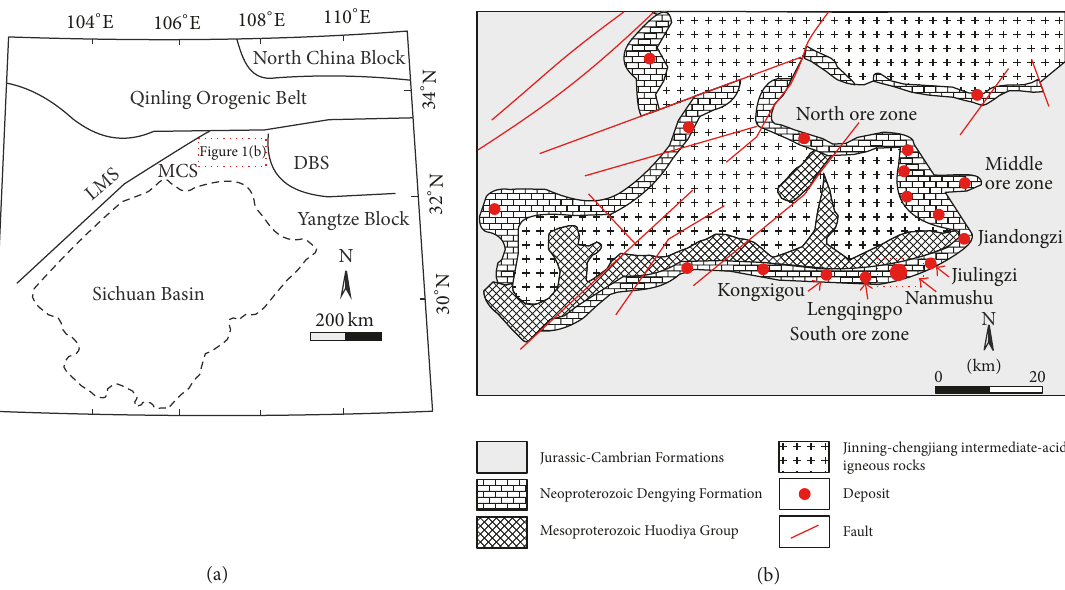
Figure 1: (a) Tectonic location of the Mayuan district. (b) The distribution of the South, Middle, and North ore zones, and major Zn-Pb deposits in the Mayuan district (modified from Hou et al., 2007 [23]). MCS, Micangshan fold-and-thrust belt; LMS, Longmenshan fold-and- thrust belt; DBS, Dabashan fold-and-thrust